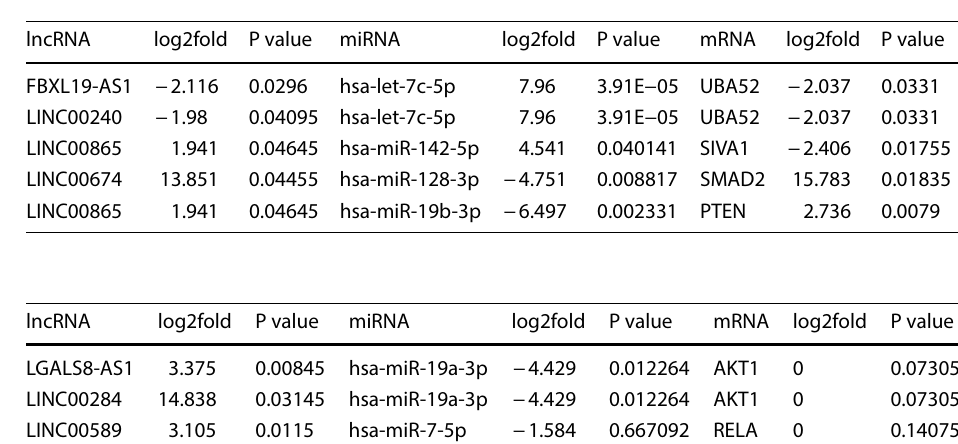
lncRNA log2fold P value